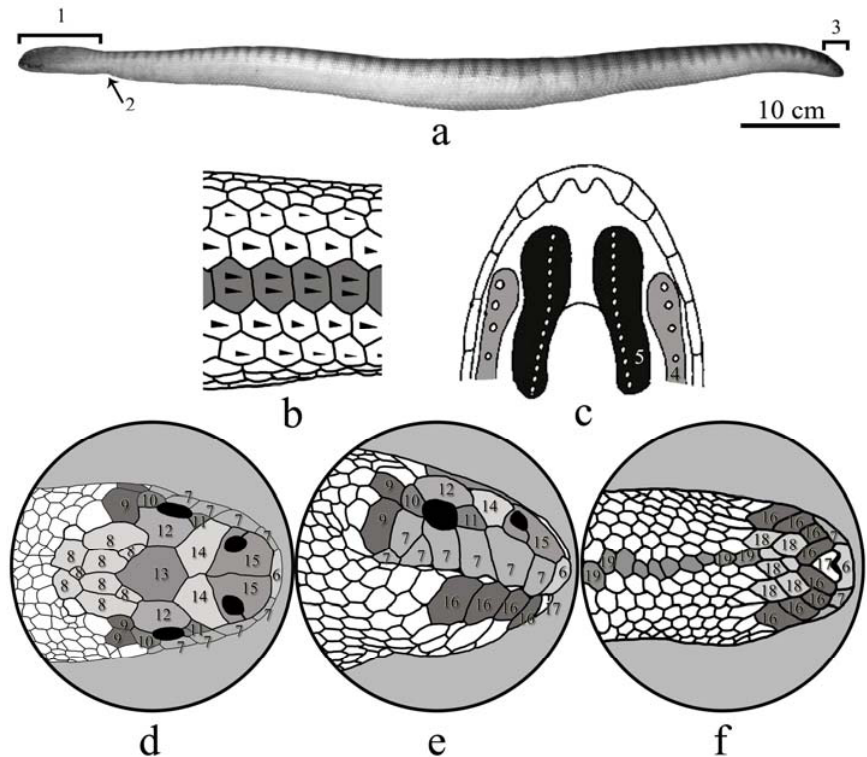
F IGURE 2. Speci fi c features of the teeth and scales. a: general aspect of L. curtus , b: ventral view of the trunk (ventral scales are highlighted), c: Upper jaw, palatine (black) and maxillary (gray) bones, d: dorsal view of the head, e: lateral view of the head, f: ventral view of the head. 1, Tail; 2, Vent; 3, Head; 4, Maxillary teeth; 5, Palatine teeth; Scales of 6, Rostral; 7, Supralabials; 8, Parietals; 9, Temporals; 10, Postocular; 11, Preocular; 12, Supraocular; 13, Frontal; 14, Prefrontals; 15,